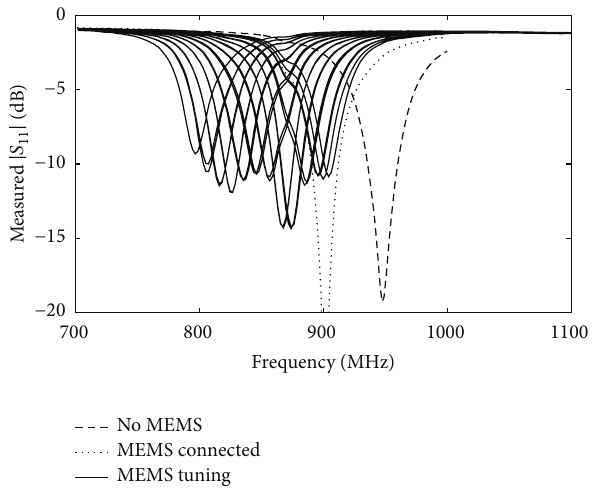
Figure 4: Measured frequency response of the demonstrator shown in Figure 3, with 𝐶 max = 4.875 pF and 𝐶